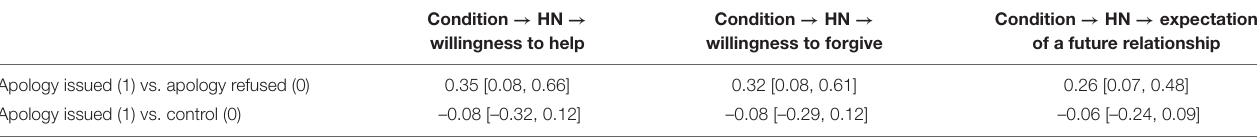
TABLE 3 | Indirect effects of condition on relationship outcome measures through human nature (HN) (Study 1).